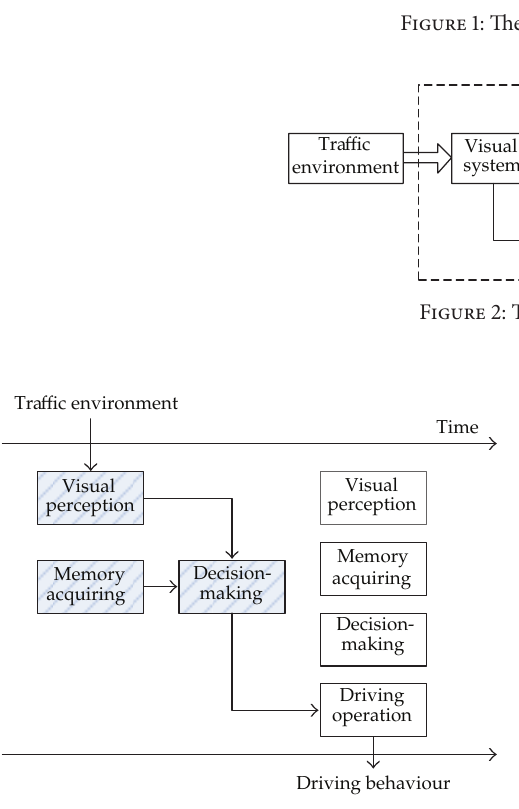
Figure 1: The architecture of cognition model.